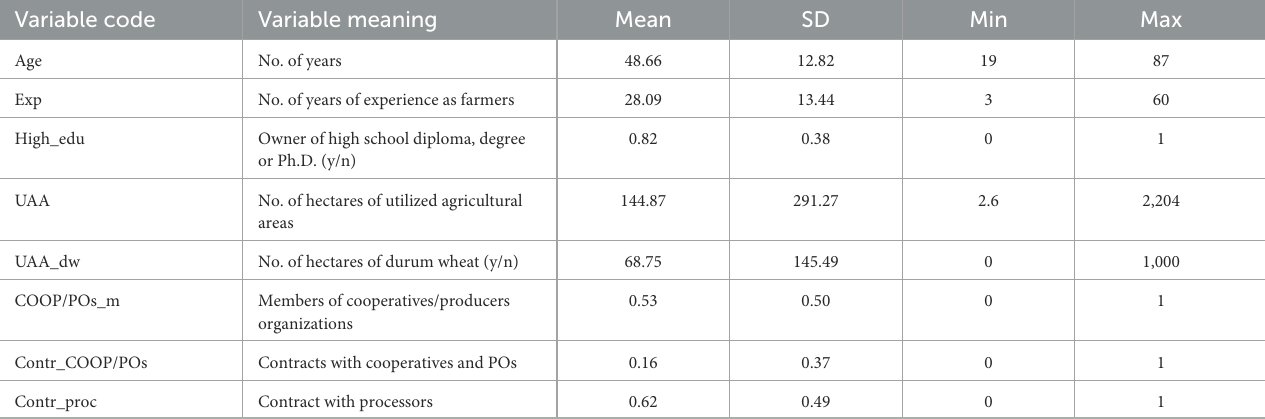
TABLE 2 Characteristics of the sampled durum wheat producers and their farms ( n =